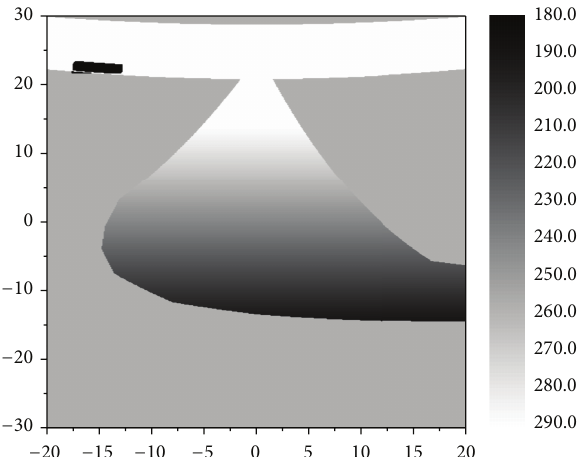
Figure 10: Simulated image of Lambertian model.